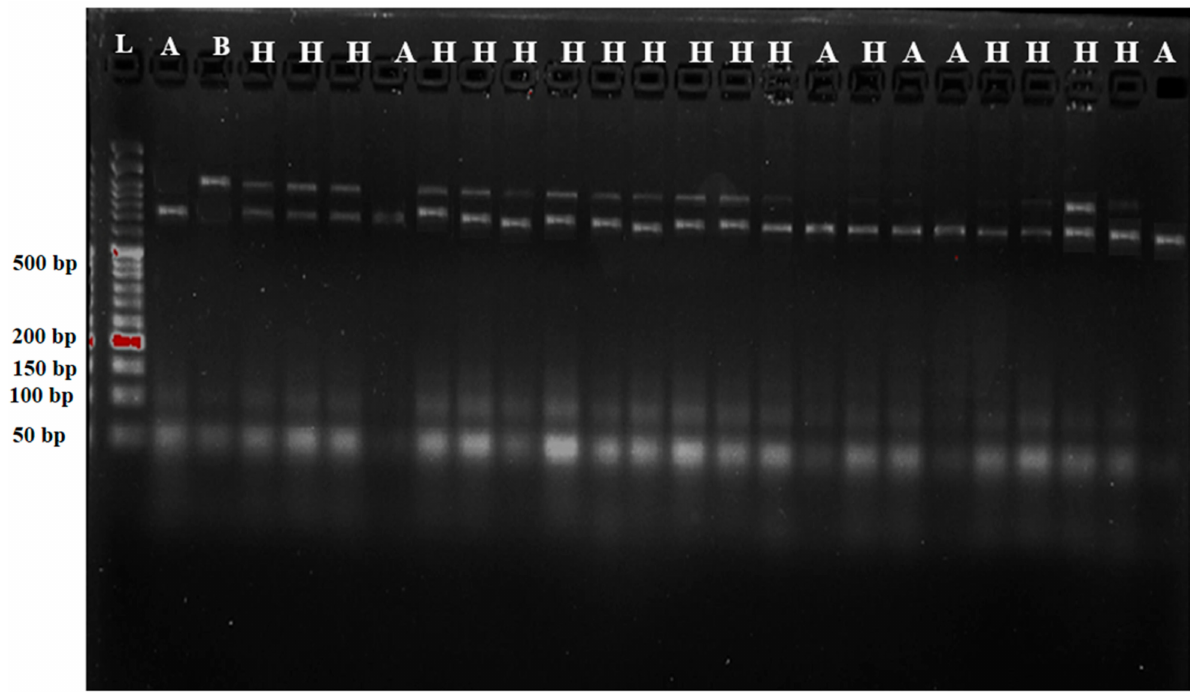
Figure 3. Genotyping and foreground marker-assisted selection of F 1 hybrids using pTA248 tightly linked marker. F 1 developed from a cross between A: MR297 and B: IRBB60. H represents heterozy- gotes; L: 50 bp DNA ladder. Table 2. The BC 1 F 1 progenies: Foreground marker segregation analysis. Functional Markers No. of Chro. Analysis of Marker Segregation (1:1) χ 2